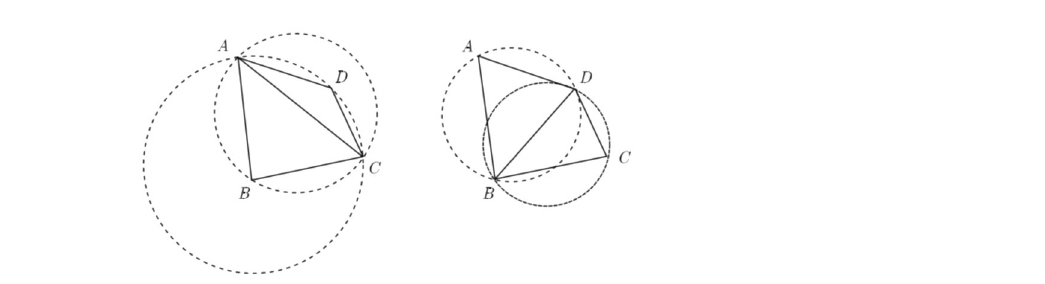
Figure 13. Diagonal transformation based on Delaunay criteria.